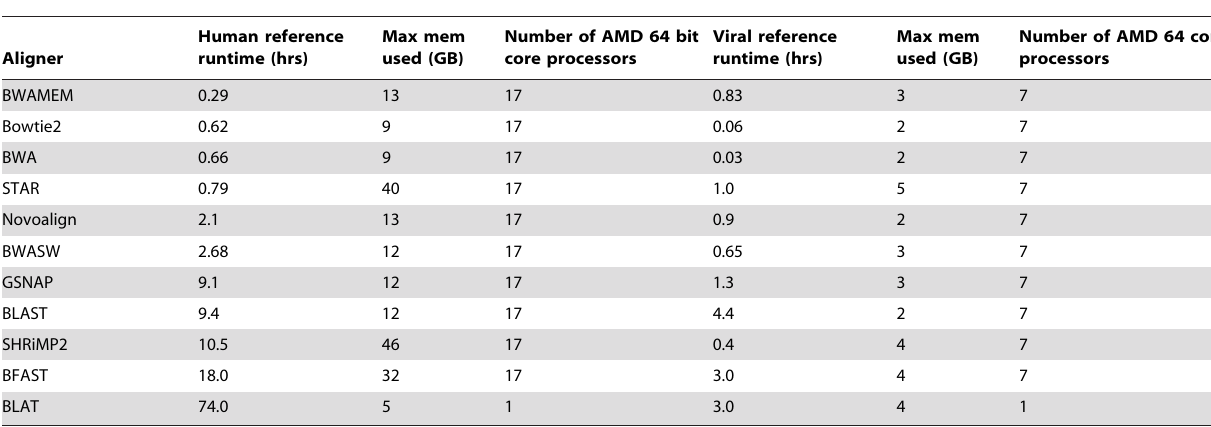
Table 10. Runtime